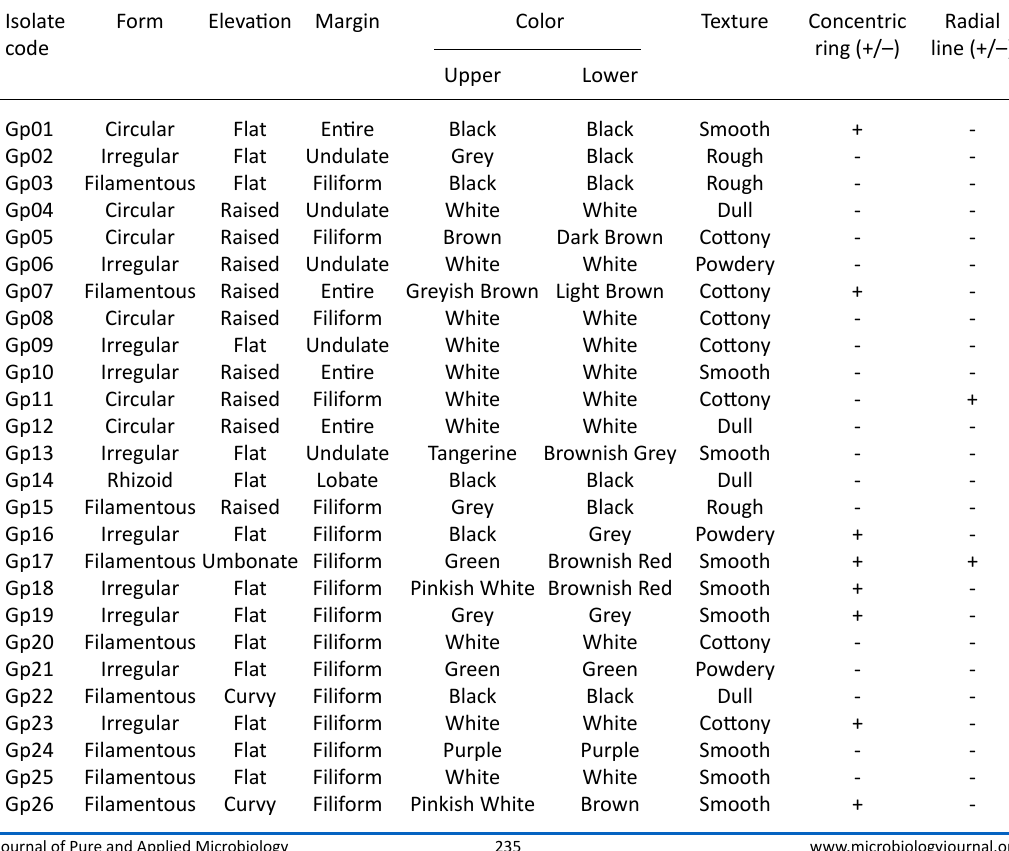
Table 1. Morphological features of 26 endophytic fungal isolates from Globba patens Miq Isolate